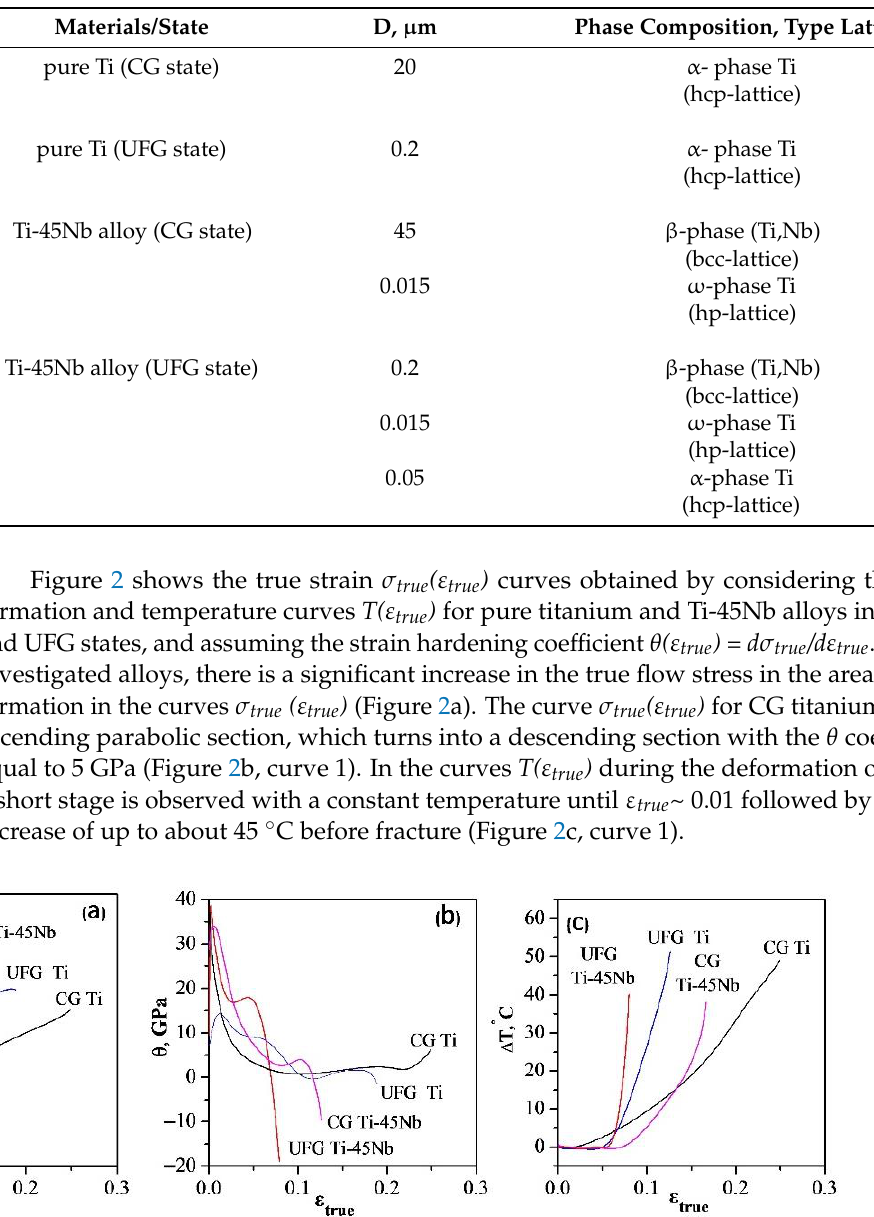
Table 1. Structural parameters and phase composition in pure titanium and Ti-45Nb alloy in the CG and UFG states.